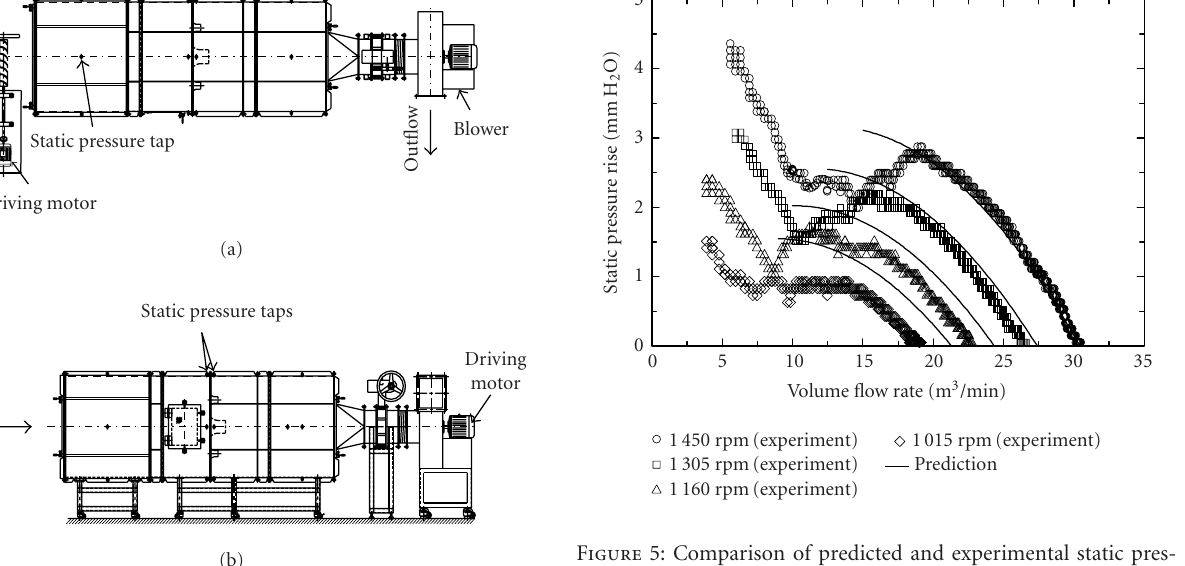
Figure 5: Comparison of predicted and experimental static pres- sure rise performances for a cross-flow fan.